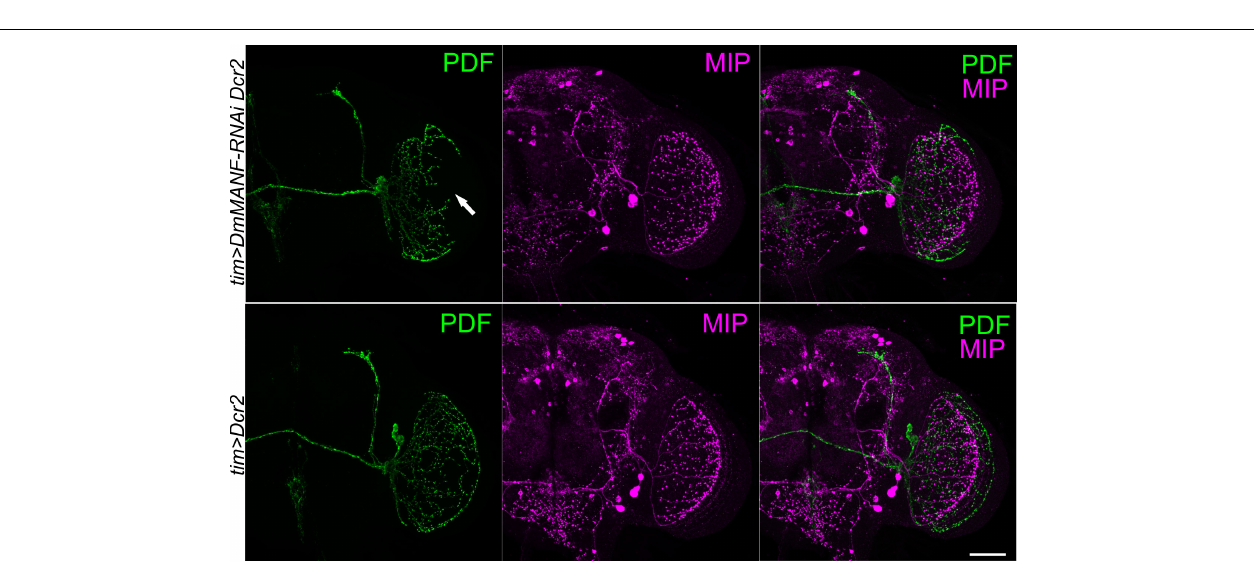
FIGURE 6 | Double labeling of PDF-positive and MIP-expressing neurons in the head of flies with silenced expression of DmMANF in clock neurons. Brains of tim > DmMANF-RNAi Dcr2 (upper panel) and tim > Dcr2 (lower panel) were double-labeled with antiserum to PDF (green) and MIP (magenta). The morphology of PDF-positive neurons terminals in the medulla (arrow) is disturbed when DmMANF is silenced. Morphology of terminals of MIP-expressing neurons in the medulla remains intact. N = 7. Scale bar: 50 µ m.